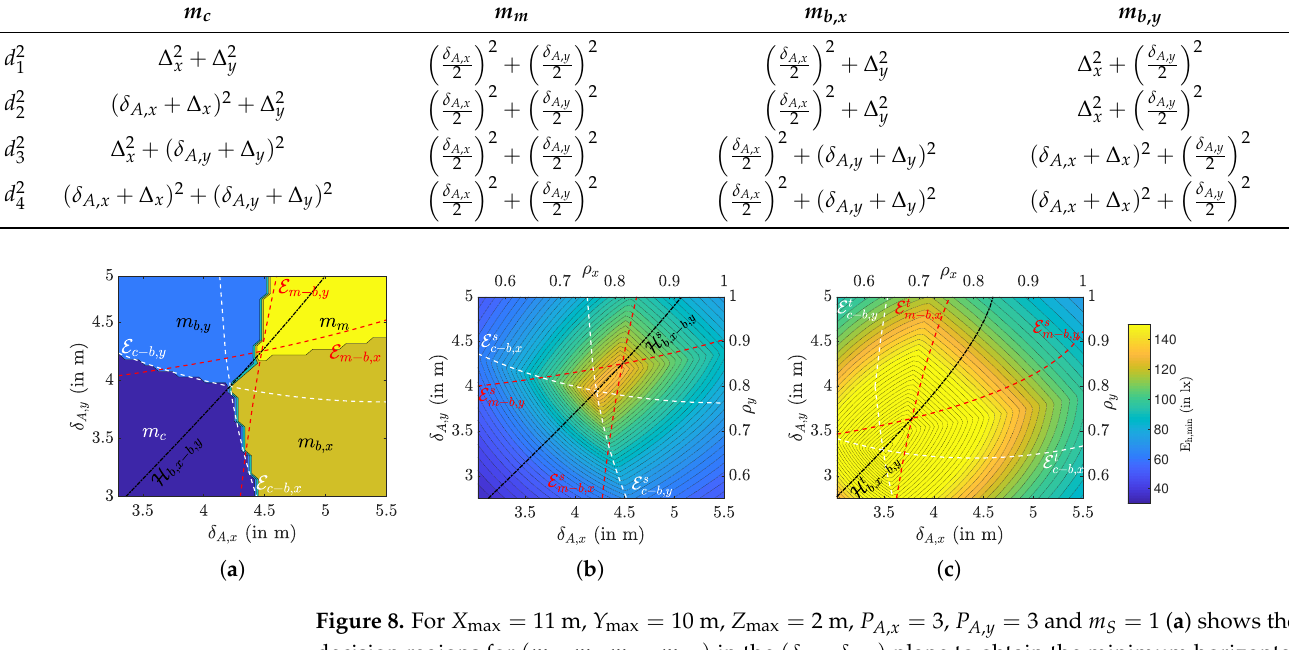
Table 2. Distances between the arrays and the reference points.